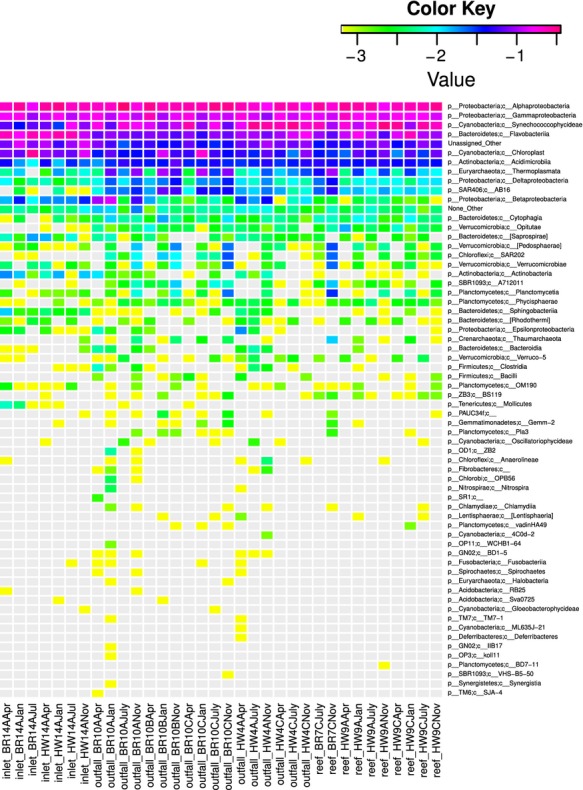
Hierarchical clustering of bacterioplankton 16S profiles at the class level. Heatmap values reflect log-normalized proportions (e.g., −1% to 10%, −2% to 1%, −3% to 0.1%) and were generated using the skiff tool in CloVR (Angiuoli et al. 2011). Relative microbial abundance is shown by the spectrum of colors on a logarithmic scale. For example, a more reddish color indicates higher abundance, while yellow indicates less common taxa.